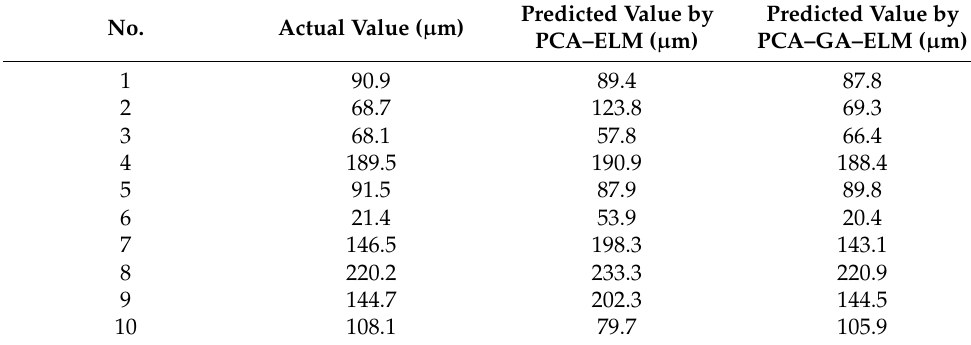
Figure 9. The prediction results of TC thickness of the ELM and GA–ELM model. Table 3. The actual value of SEM observation of TC layer and the predicted value of the two